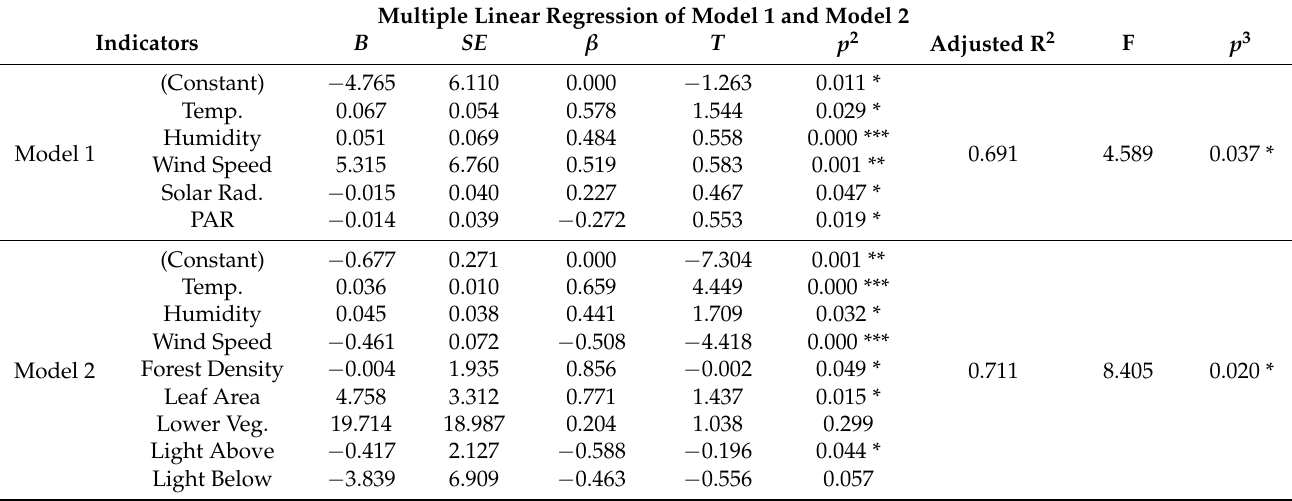
Table 3. Results of regression analysis for selecting significant visual indicators. Multiple Linear Regression of Model 1 and Model